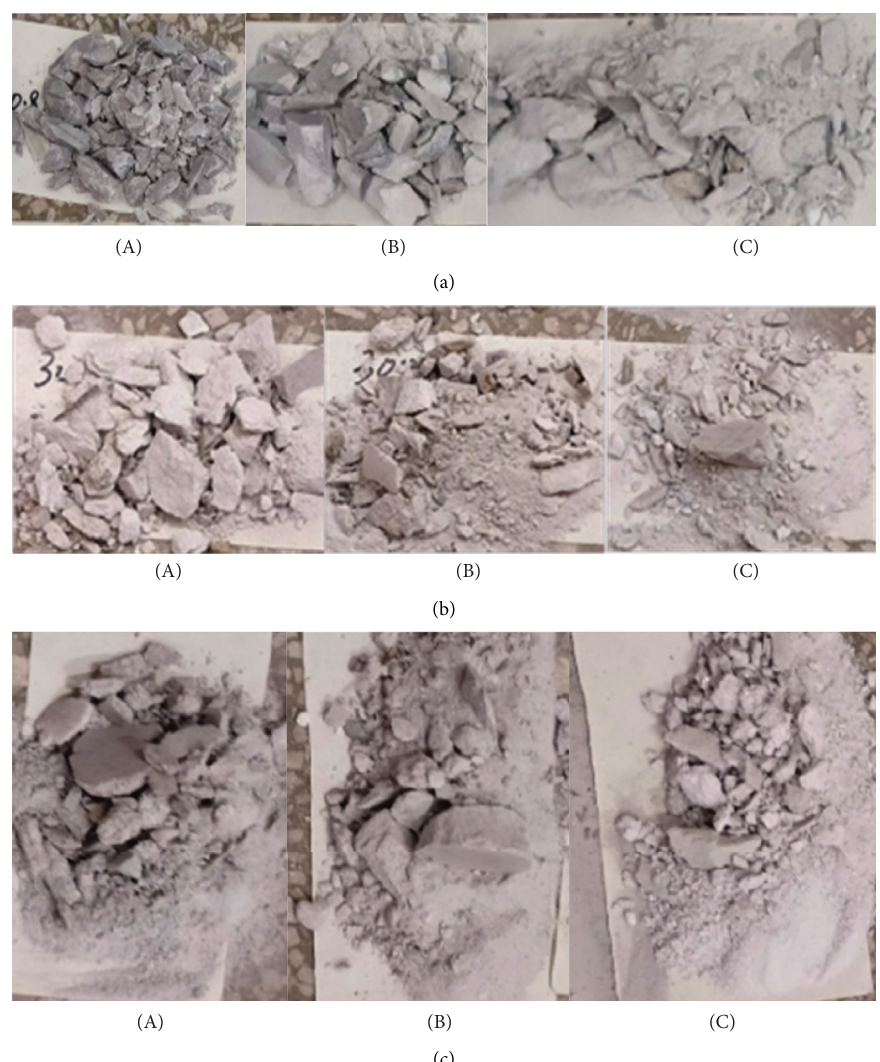
Figure 13: Rock fragments produced by the UCS test under coupled temperatures and strain rates. (a) I 25 ° C: (A) 84.7 s − 1 , (B) 87.1s − 1 , and (C) 127.8s − 1 . (b) II 400 ° C: (A) 104.7s − 1 , (B) 07.1s − 1 , and (C) 137.8s − 1 . (c) III 600 ° C: (A) 200.7s − 1 , (B) 217.1 s − 1 , and (C) 57.8s − 1